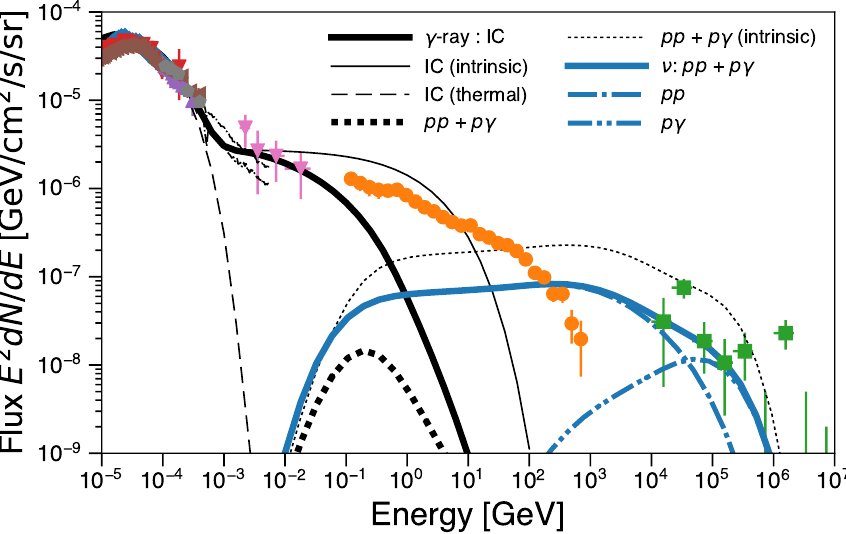
Figure 12. The cosmic Gamma-ray and neutrino background spectra from AGN coronae with p inj = 2.0 and η g = 30. Each component is labeled as in the figure. Thin curves show the spectra before the attenuation. The circle-orange and square-green data points correspond to the total cosmic Gamma-ray background spectrum measured by Fermi /LAT [73] and the cosmic neutrino background spectrum by IceCube [145], respectively. The cosmic X-ray and MeV Gamma-ray background spectrum data of HEAO -1 A2 (triangle-brown; [140]), INTEGRAL (triangle-red; [141]), HEAO -1 A4 (triangle-purple; [142]), Swift -BAT (diamond-blue [143]), SMM (black-thin-dot-dashed [67]), Nagoya– Ballon (pentagon-gray; [66]), COMPTEL (pink-triangle; [144]) are also shown in the figure. Taken from Inoue et al.